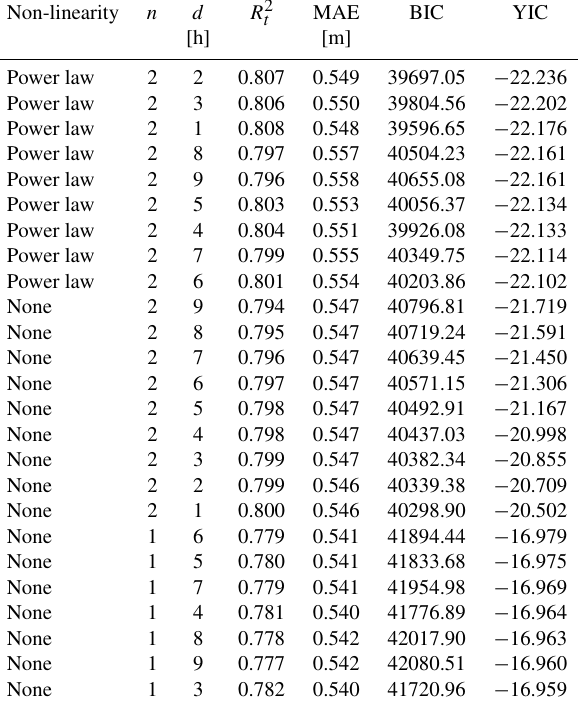
Table 4. Summaries of the performance of a subset of models dur- ing the calibration period (1 April 2011–1 September 2013). This shows a clearer definition of the preferred model then results in Ta- ble